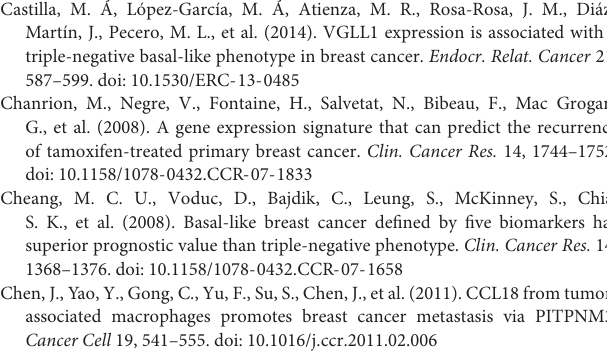
FIGURE S1 | Correlation between CD24 copy number alterations and mRNA expression. (A) Change of CD24 mRNA expression between all tumor samples ( N = 1082) and normal samples ( N = 112) from TCGA BRCA cancer studies. (B) Change of CD45 mRNA expression between CD24 higher expression groups ( CD24 exp high, N = 541) and CD24 lower expression samples ( CD24 exp low, N = 541) from TCGA BRCA studies. (C) Kaplan–Meier OS curves comparing the high and low expression value of CD24 for two independent BRCA patient cohorts. (D) Kaplan–Meier metastasis survival curves comparing the high and low expression value of CD24 for two independent BRCA patient cohorts. Statistical significance was determined by One-way ANOVA in panel (A) , the Wilcoxon test in panel (B) , and the log-rank test in panels (C,D)